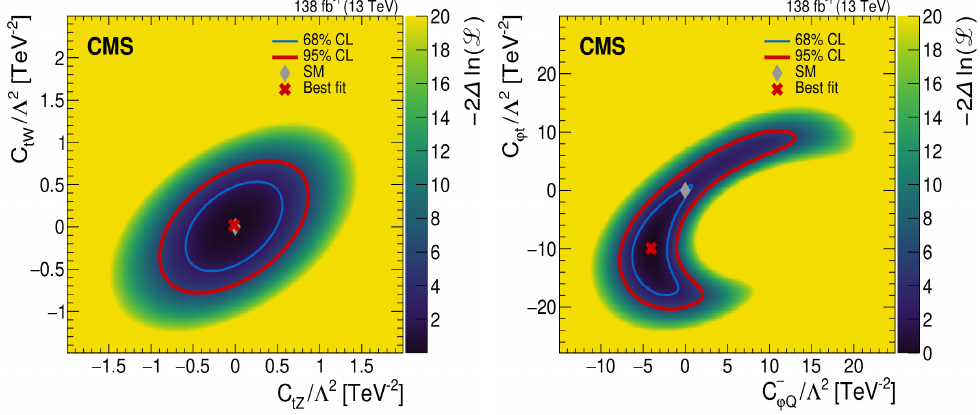
Figure 10. 95% CL confidence intervals for the 2D fits in